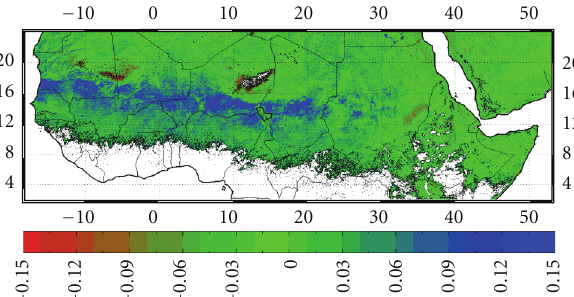
Figure 6: Mean August-September-October broadband surface albedo absolute di ff erence between year 1984 and 2003 over the Sahel region. Missing data are shown in white. Courtesy by Dr. Yves Govaerts of EUMETSAT Based on Govaerts and Lattanzio